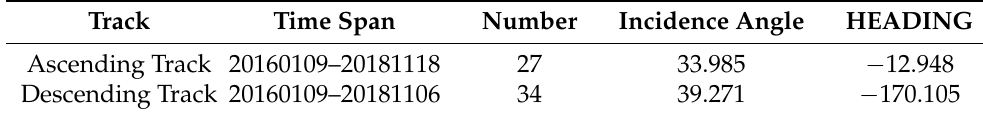
Figure 5. Topographic map of the study area. The black triangles represent the position of GNSS stations. The four characters next to each GNSS station represent its name. Table 1. SAR data parameters used in the Los Angeles